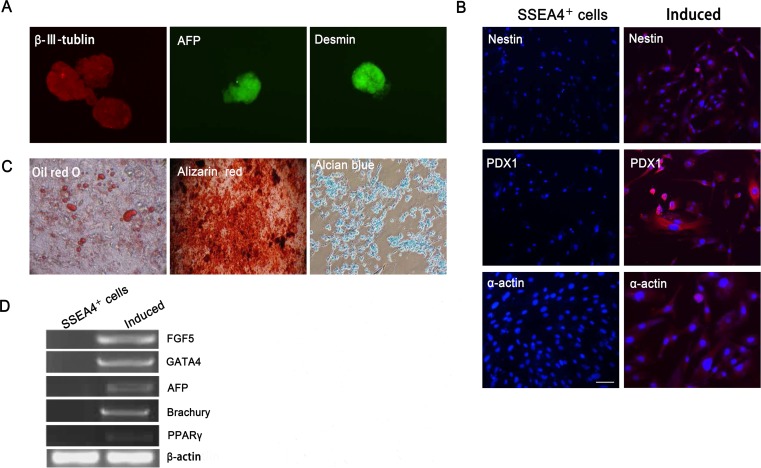
The differentiation potential of SSEA-4+ cells in vitro.(A) The floating spheres derived from SSEA-4+ cells spontaneously differentiated into the three types of germ layers expressing specific markers for each, including β-III-tubulin (ectoderm), AFP (endoderm) and Desmin (mesoderm). (B) SSEA-4+ cells differentiated into specific cells as determined by immunofluorescence analysis for Nestin, PDX1, and α-actin expression, respectively. (C) In vitro differentiation of SSEA-4＋ cells into adipocytes, osteocytes, and chondrocytes assayed using Oil red O stain for adipogenesis, Alizarin Red stain for osteogenesis, and Alcian blue stain for chondrogenesis. (D) RT-PCR assay for specific markers of the three germ layers including FGF5, GATA4, Brachury, AFP, and PPARγ. β-actin was used as the internal control. Scale bar = 50 μm.